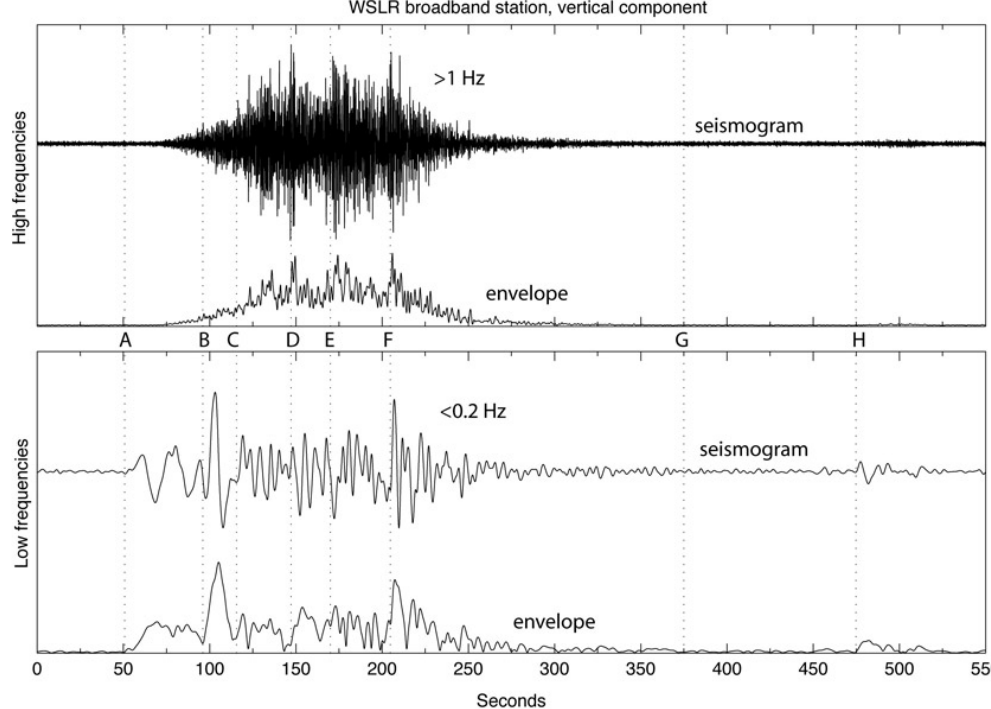
Fig. 8. WSLR broadband recording of the landslide single-pass highpass filtered ( > 1Hz top) and lowpass filtered ( < 0.2Hz, bottom) and plotted with envelopes. Dashed vertical lines are labeled with letters that correspond to Fig. 9 and discussion in text.